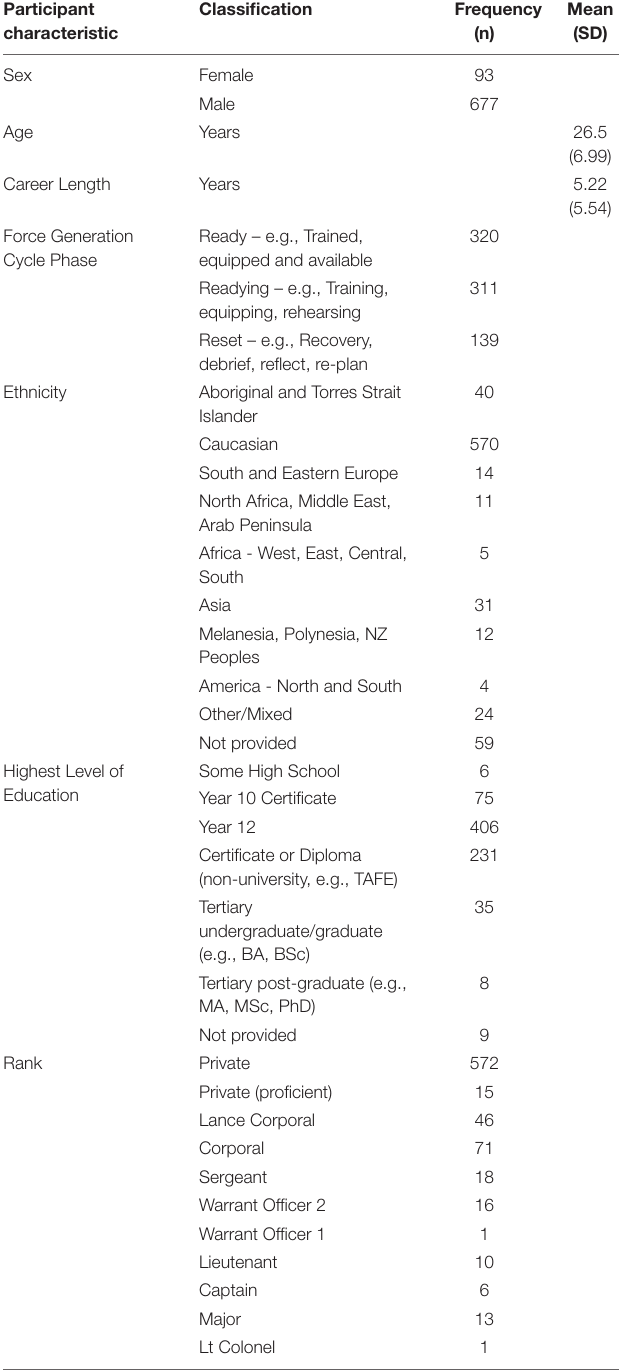
TABLE 1 | Summary of participant